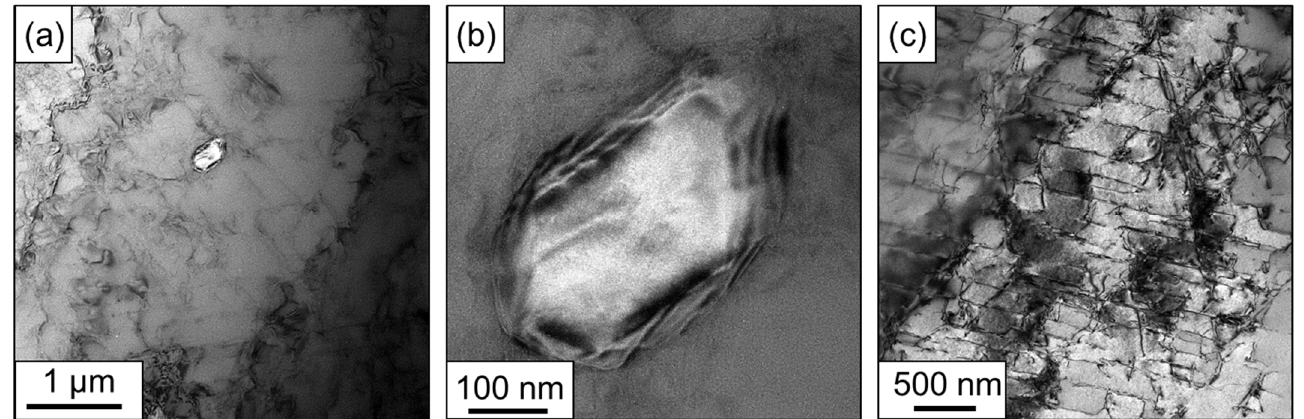
Figure 2. Bright-field images of the wrought 945A Ni-based alloy: ( a ) morphology of low magnifica- tion, ( b ) high magnification of the second phase in ( a ), ( c ) the residual